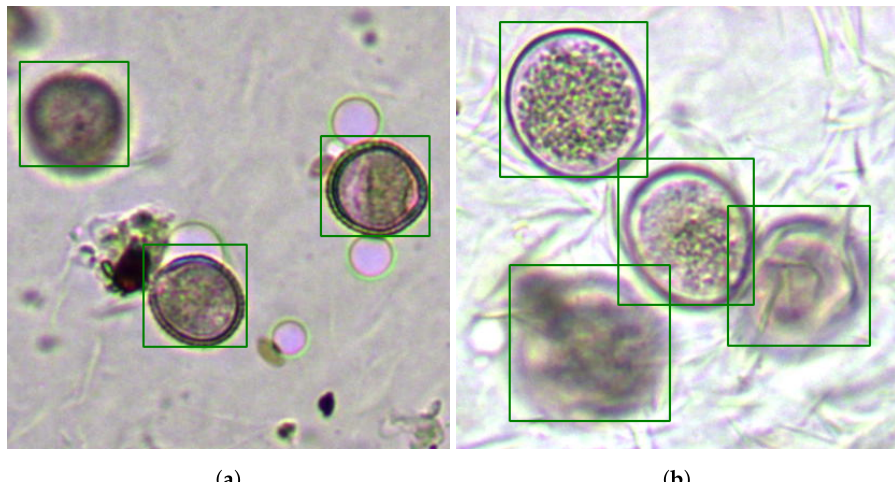
Figure 10. Two examples of grain location on samples of Olea ( a ) and Lolium ( b ) in which some of the problems identified have been successfully managed: ( a ) ignored debris, bubbles, and dust and ( b ) overlap between grains and highly-different focal planes for each grain.